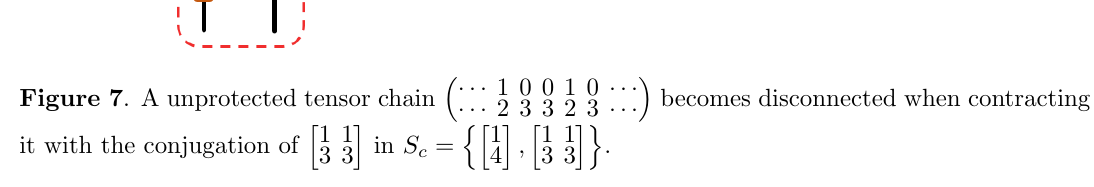
Figure 7 . A unprotected tensor chain it with the conjugation of